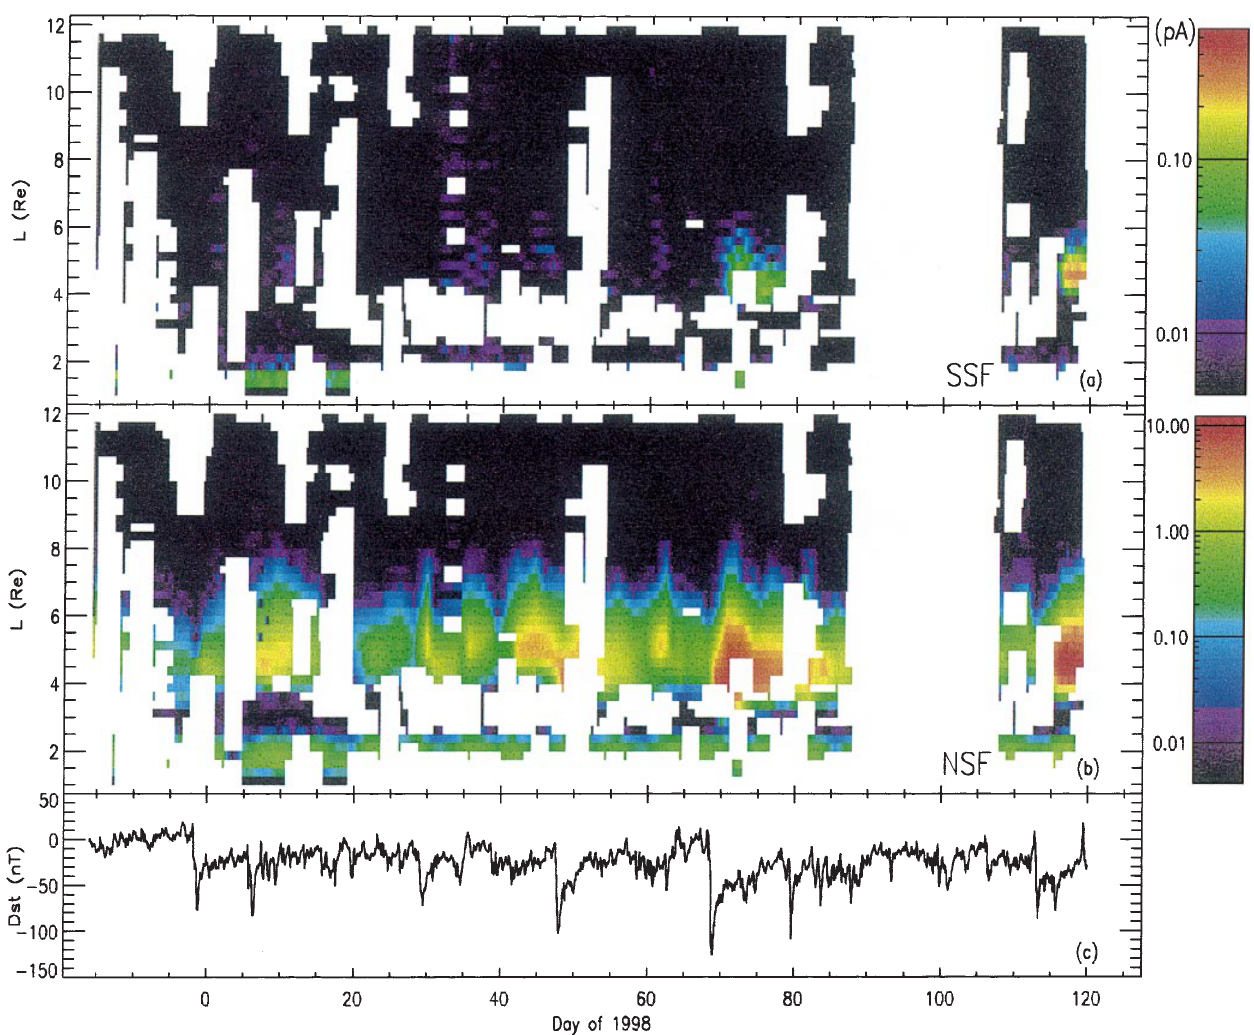
Fig. 3. Dynamical changes of the SSF ( a ) and the NSF ( b ) output current versus L and time along the EQUATOR-S orbit. The height of the bins is 0.25 in L and 0.25 days in time. A linear interpolation over a maximum of 10 time bins fills some of the data gaps between orbits.